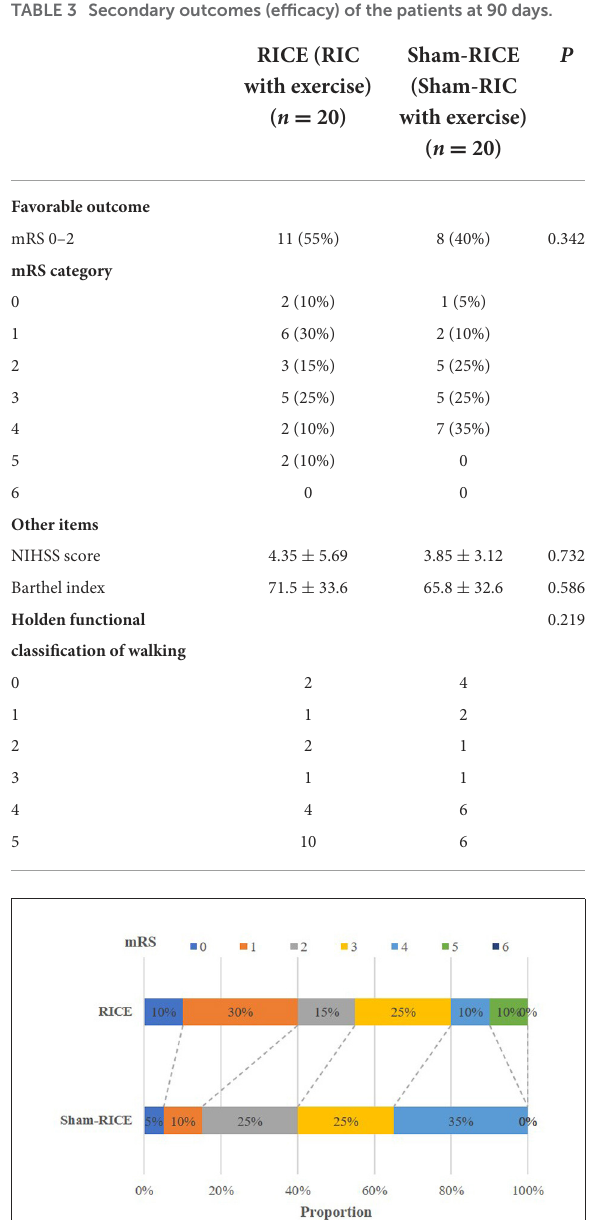
sample size are needed to confirm this conclusion, the current study indicates that RICE was safe for AIS